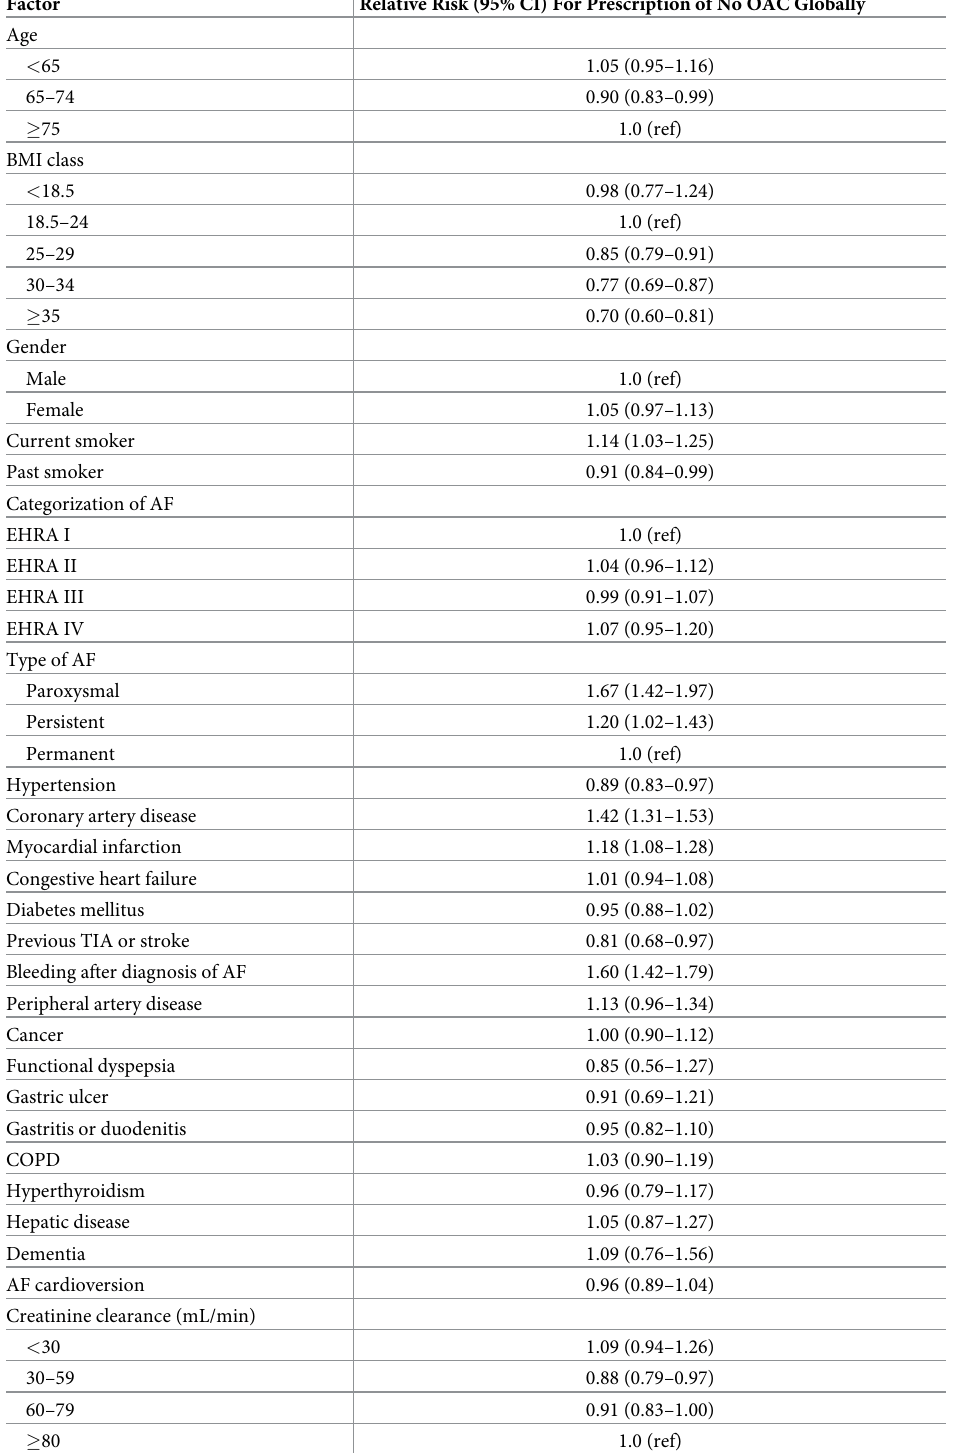
Table 5. Multivariable log-binomial analysis for factors associated with prescription of OAC therapy (no OAC vs OAC) a,b